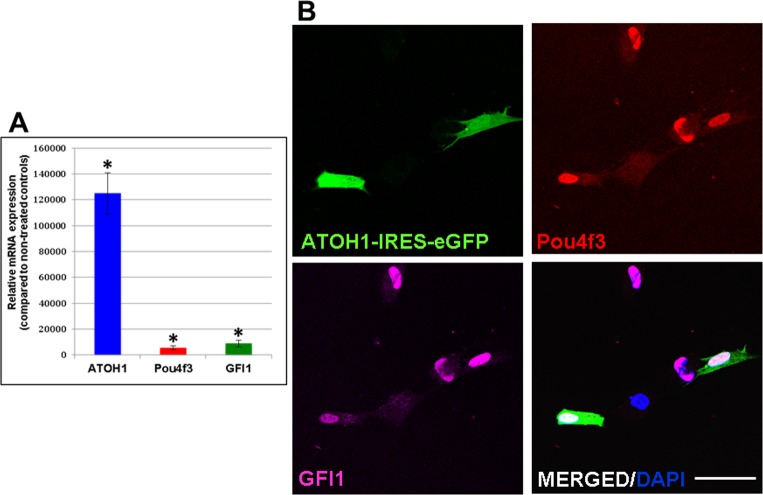
Overexpression of the GPA genes in hFIB cultures.(A) Significantly increased mRNA expression of the genes was observed compared to non-infected control cultures by qPCR analyses. Asterisks: p-value<0,05. (B) GPA protein expression in hFIB cultures simultaneously transduced with pSIN-EF2-Pou4f3-Pur, pSIN-EF2-GFI1-Pur and pLV-ATOH1-IRES-eGFP lentiviruses. Immunostaining of GPA hFIB cultures indicated that a high rate of the GFP(+) cells also expressed the Pou4f3 and the GFI1 proteins. Scale bar: 50μm.